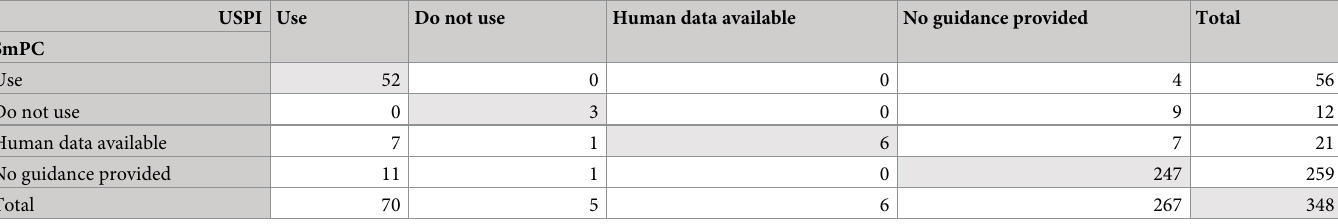
Table 5. Concordance of the level of guidance for pediatric use in the SmPC and the USPI for adolescents ( n = 348). For the other age groups, please see S2–S4 Tables. USPI Use Do not